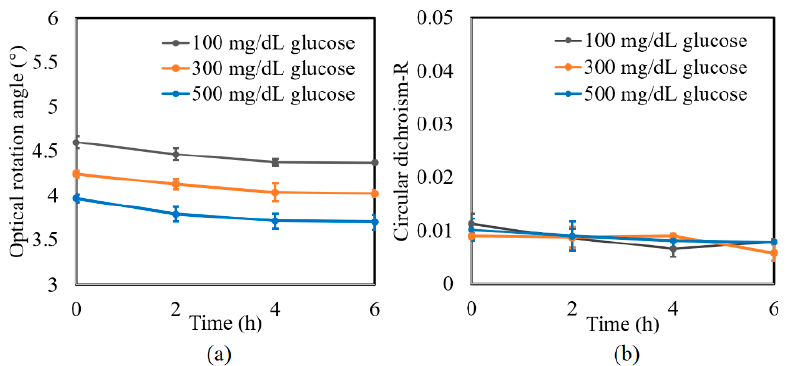
Figure 4. Experimental results for variation in: ( a ) γ and ( b ) R of glucose tissue phantom solutions mixed with 1000 mg/dL of albumin over time interval of 6 h. Figure 3. Experimental results for variation in R with: ( a ) glucose concentration as a function of albumin concentration, and ( b ) albumin concentration as a function of glucose concentration.